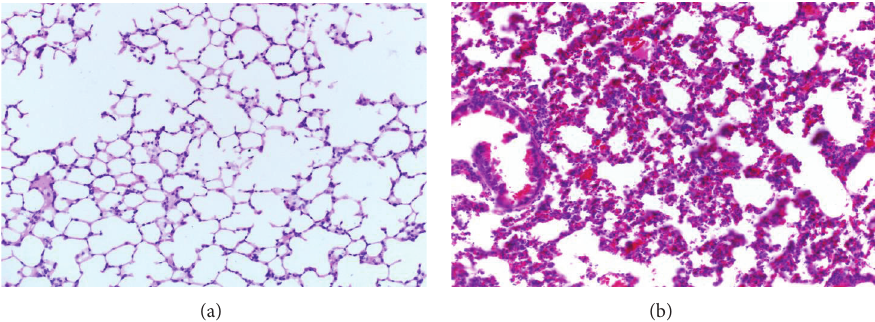
Figure 6: Representative H&E sections of pulmonary tissues (magnification, 100x). After treatment, the control group (a) had no obvious inflammation and the mtDNA (b) showed typical symptoms of acute lung